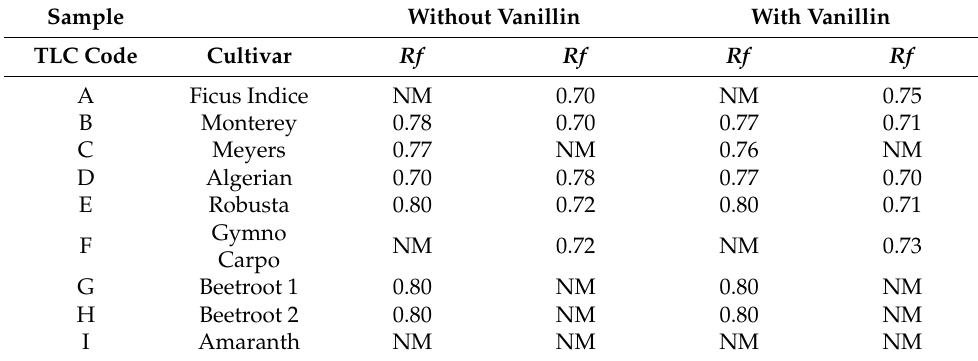
Table 3. Rf values calculated for TLC samples with (Figure 1) and without vanillin (Figure 2).